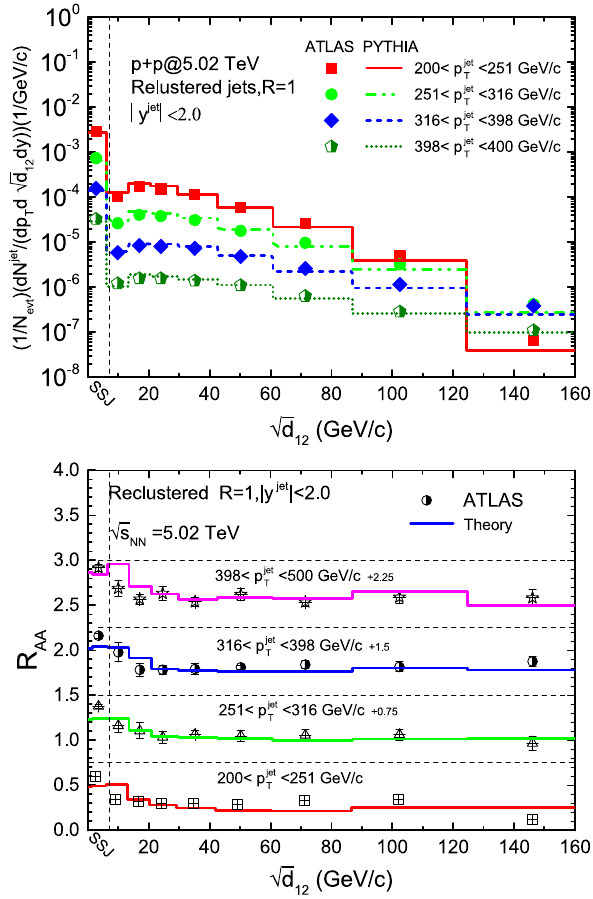
Fig. 4 Distributions of splitting scale in different reclustered LR jet transversemomentumintervalsinp+pcollisionsaswellasthecompar- ison with the experimental data [83] (top panel). Nuclear modification factor evaluated as a function of the splitting scale reclustered LR jet transverse momentum intervals as well as the com- parison with the experimental data [83] at